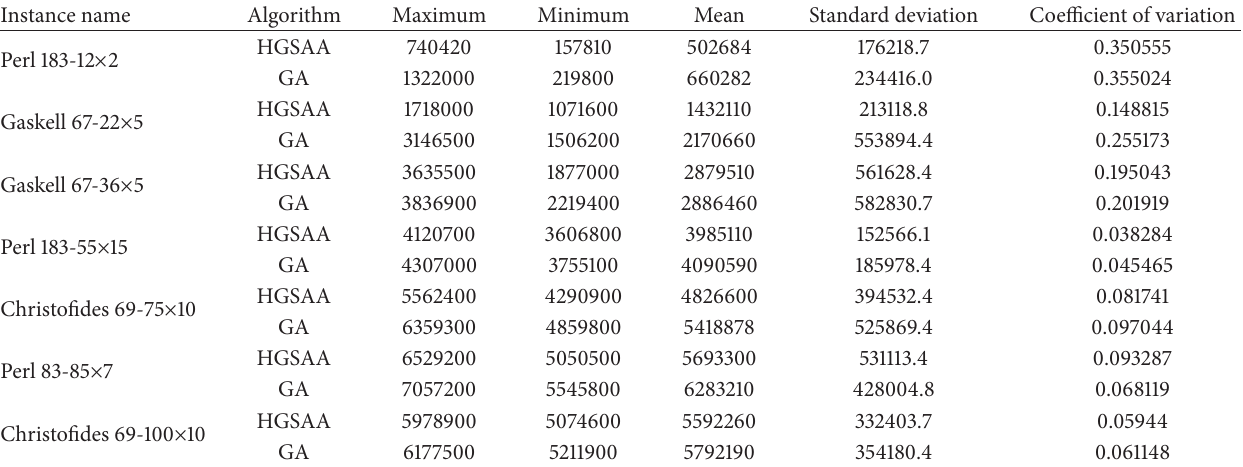
Table 4: Optimal objective function values of two algorithms.